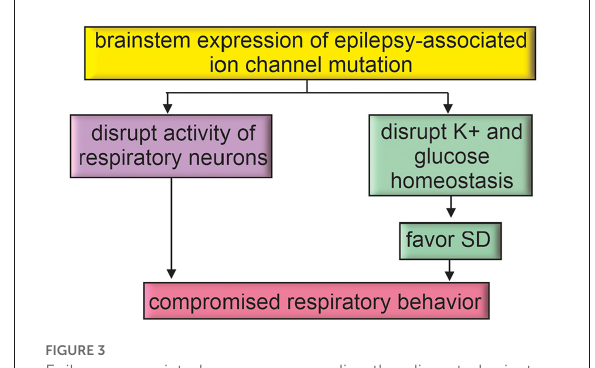
FIGURE3 Epilepsy-associated genes may directly disrupt brainstem function. Brainstem expression of epilepsy-associated ion channel mutations may directly impact respiratory function or favor mechanisms for SD propagation to the